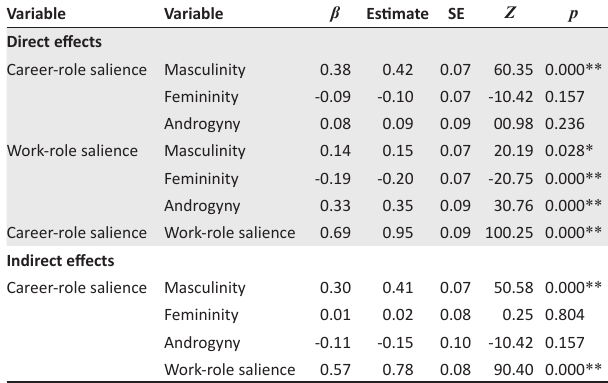
TABLE 3: Path analysis of indirect and direct effects.